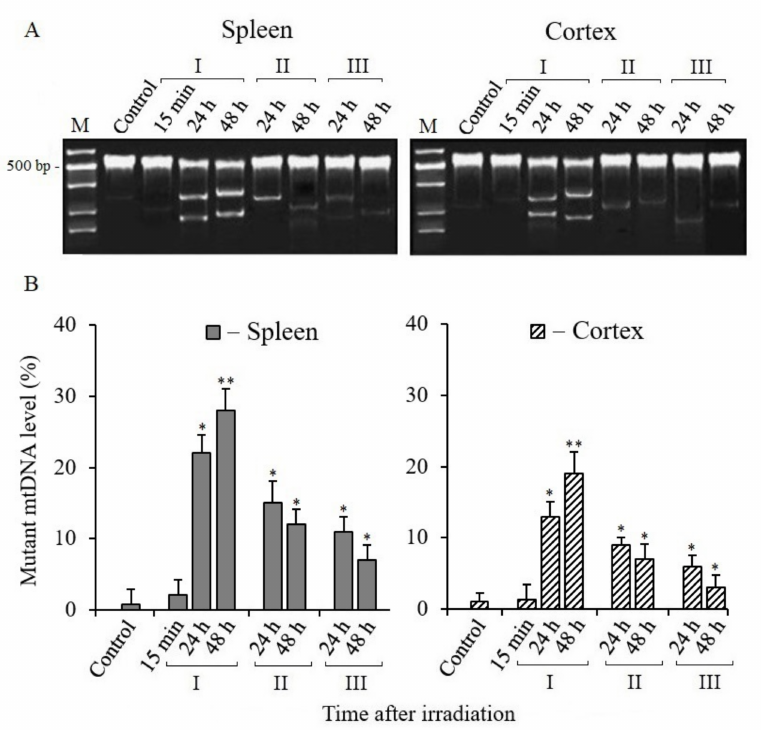
Figure 3. Detection of mtDNA mutant copies of spleen and cerebral cortex tissues in mice 15 min, 24, and 48 h after X-ray irradiation. ( A ) Electrophoresis of cleavage products obtained by Surveyor nuclease digestion of heteroduplexes of mtDNA PCR amplicons from spleen and cerebral cortex tissues. ( B ) Percentage of Surveyor nuclease cleaved heteroduplexes of PCR amplicons of mtDNA (ND3 gene, 534 bp). I—mice without MEL administration; II—MEL administration before